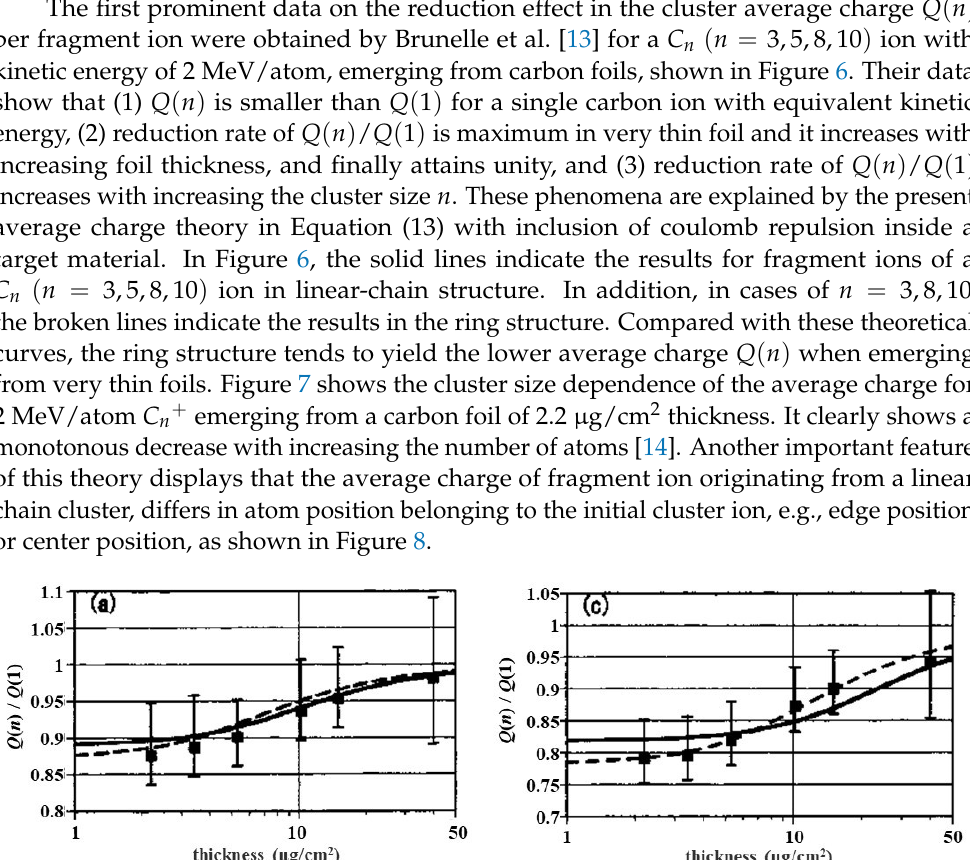
Figure 6. Foil-thickness dependence of Q ( n ) / Q ( 1 ) for 2 MeV/atom C n + cluster ions, emerging from carbon foil, with the experimental data [13]. ( a ) n = 3, ( b ) n = 5, ( c ) n = 8, ( d ) n = 10. Solid lines and broken lines refer to linear-chain structure and ring structure [14].